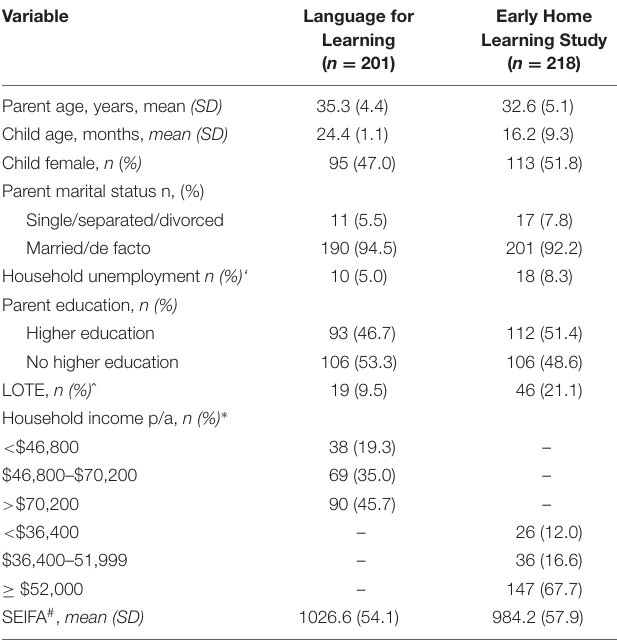
TABLE 2 | Sample characteristics for participants in each